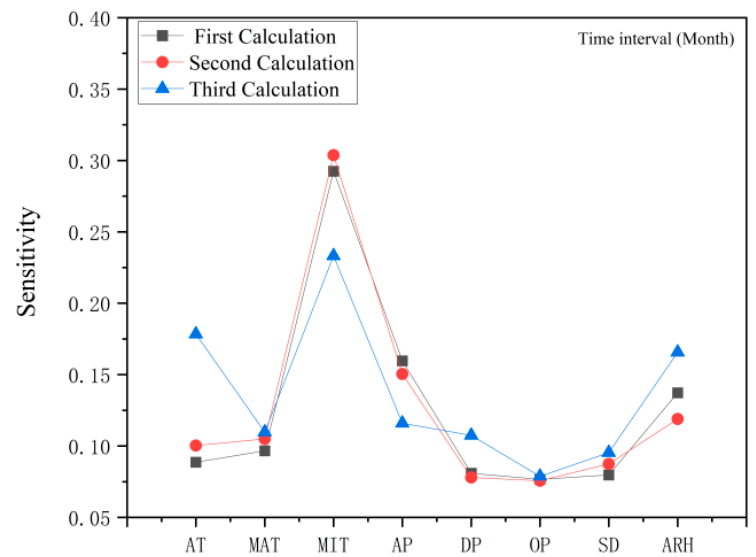
Figure 4. Response of total flavonoid content to climate factors based on the Artificial Neural Network Model. AT: Average temperature per month; MAT: Maximum temperature per month; MIT: minimum temperature per month; AP: Average precipitation per month; DP: Daytime precipitation per month; OP: Overnight precipitation per month; SD: Sunshine duration per month; ARH: Average relative humidity per month.